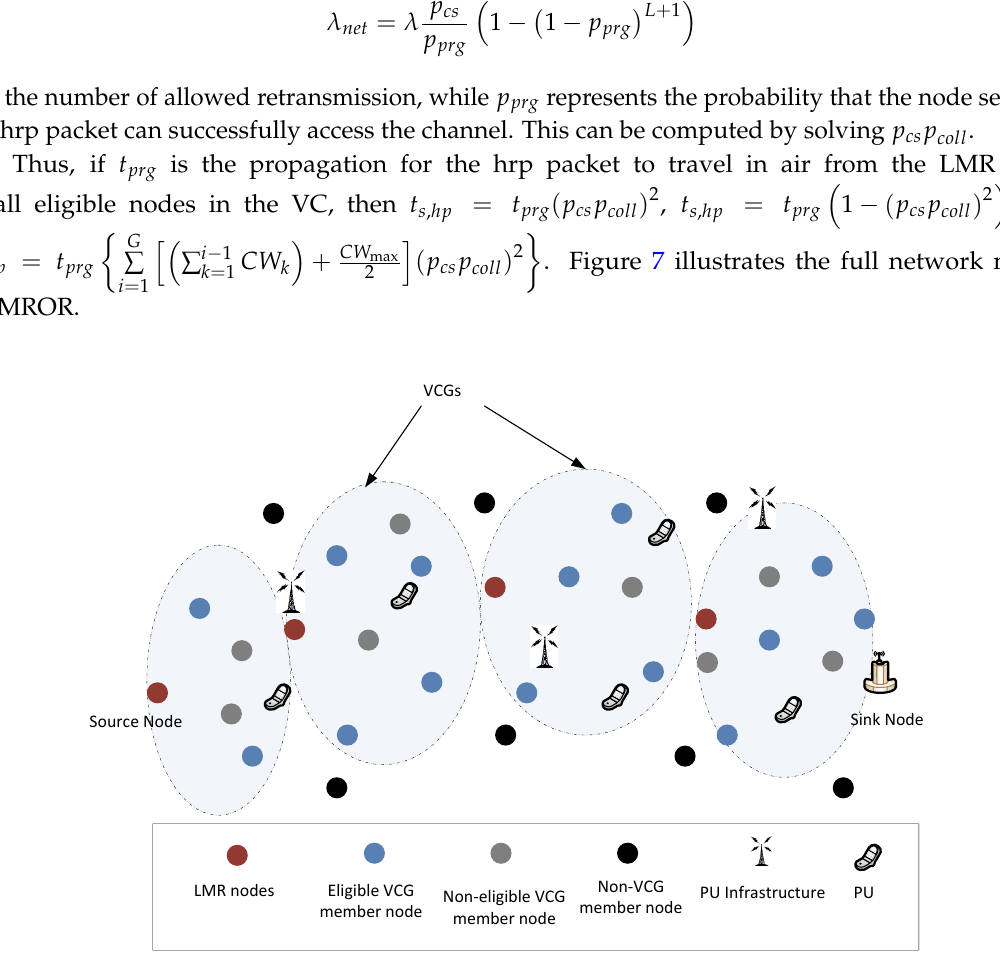
Figure 7. Full network illustration for a mobile reliable opportunistic routing (MROR)-based cognitive radio sensor network